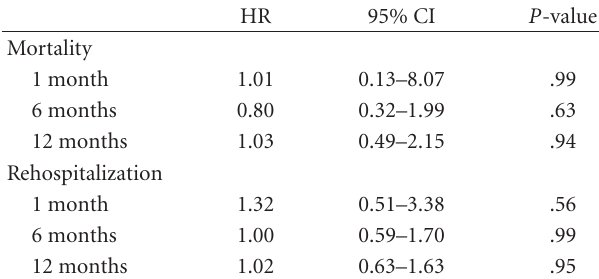
Table 3: Association of WRF (CRE) with mortality and rehospital- izations risks.